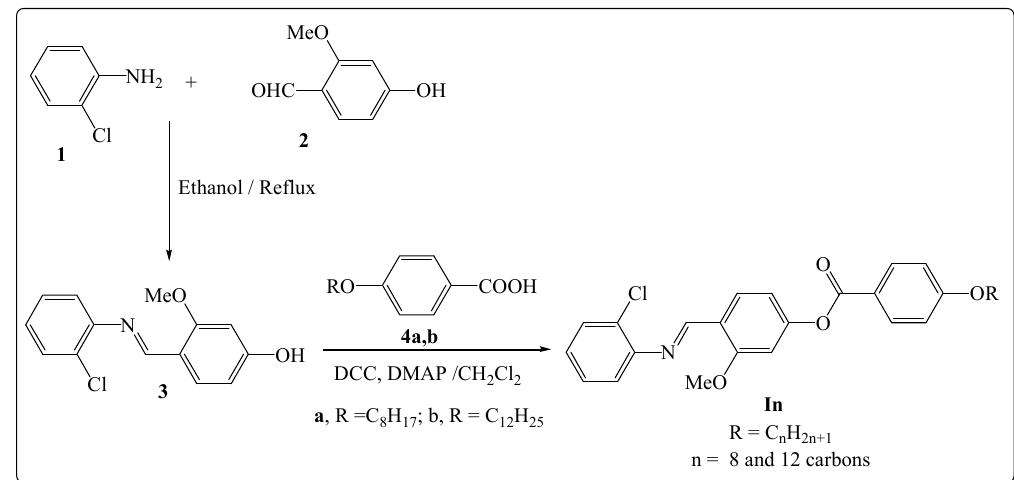
Scheme 1. Synthesis route of the title compound, In .